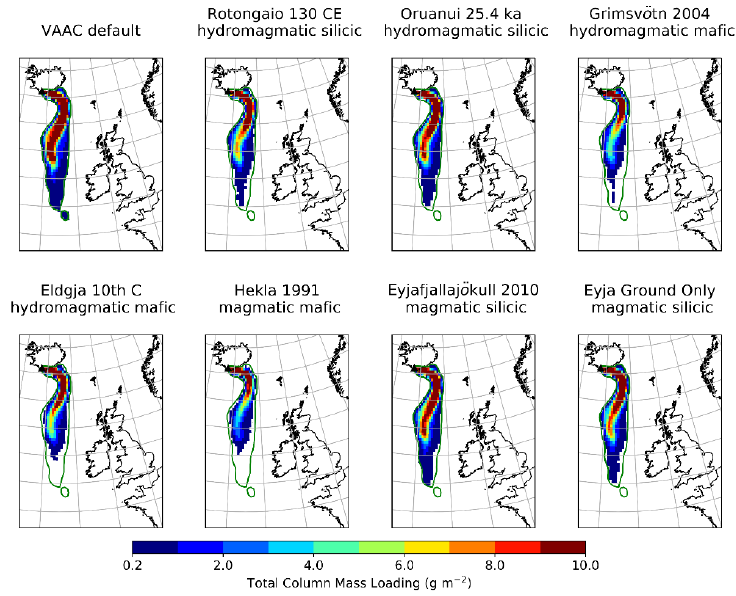
Figure 9. Total column mass loadings for 6 May 2010 12:00 UTC using a range of input PSDs. The extent of plume using VAAC default PSD is shown as a green outline on each